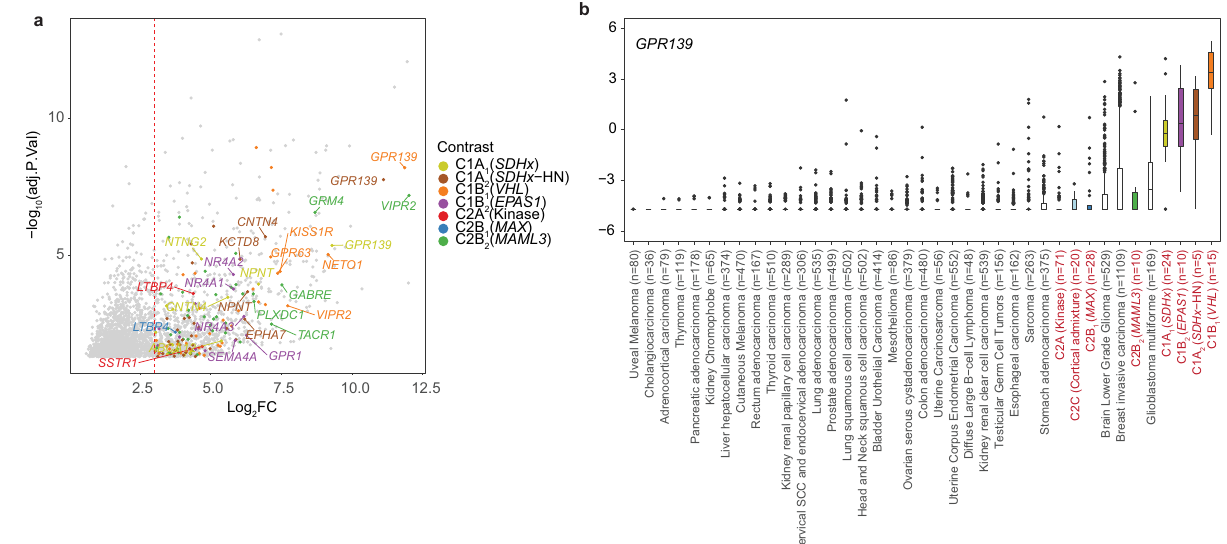
Fig. 7 | Identi fi cation cell surface receptors as putative therapeutic targets. a Volcano-plot showing signi fi cantly DE genes (adj. p -value<0.05) found by con- trasting pseudo-bulked NEO cells and NAM chromaf fi n cells based on PCPG sub- type(SupplementaryData5).Onlythose genesencodingcellsurfacereceptorsare colored, with top receptors in each PCPG subtype labeled. The dotted line shows log2threefoldchangethresholdusedforselectingreceptorgenes. b Expressionof GPR139 across tumor types in the TCGA pan-cancer dataset of 10,211 tumors from